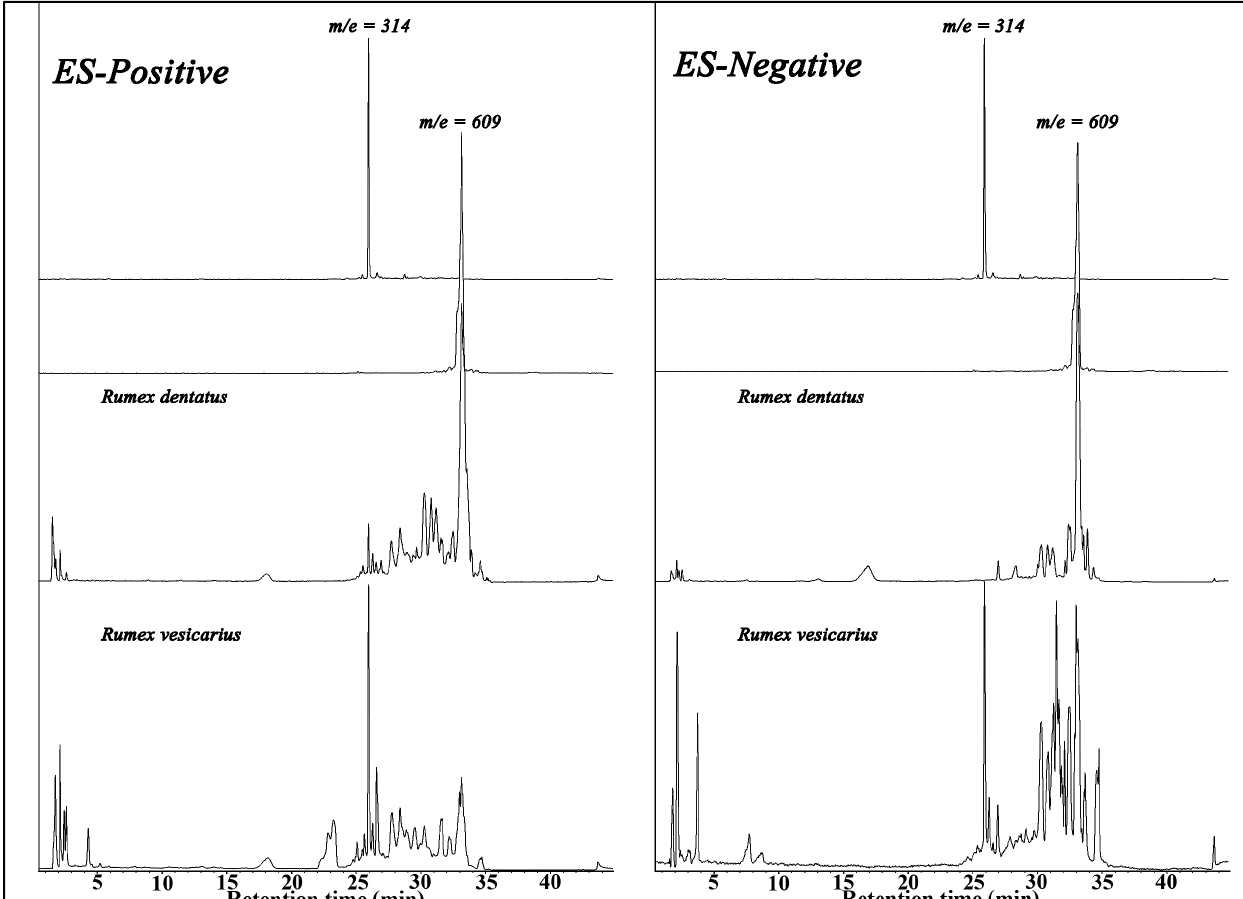
Figure 6. ESILCMS chromatograms of Rumex dentatus and Rumex vesicarius